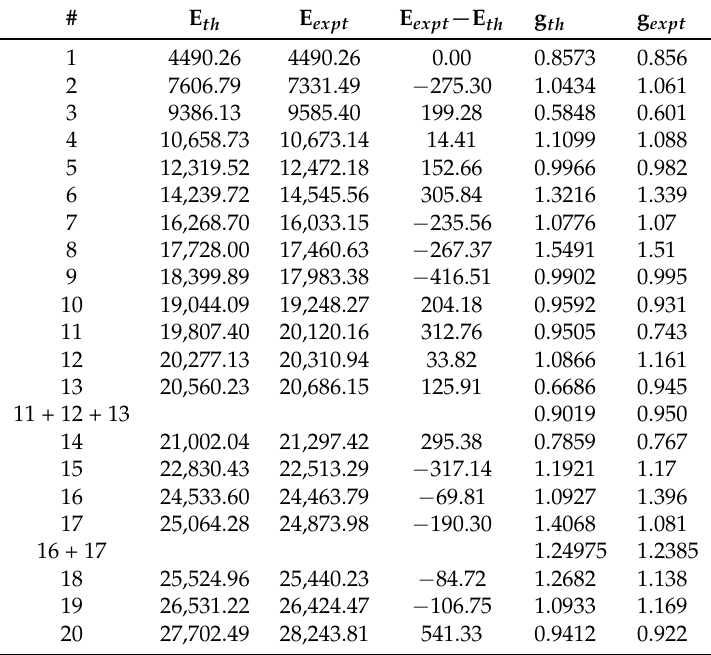
Table 3. Energies (cm − 1 ) and g-factors for optimized parameters presented in Table 1 for J = 2.5 odd states. The experimental energies and g-factors are taken from NIST database [21].